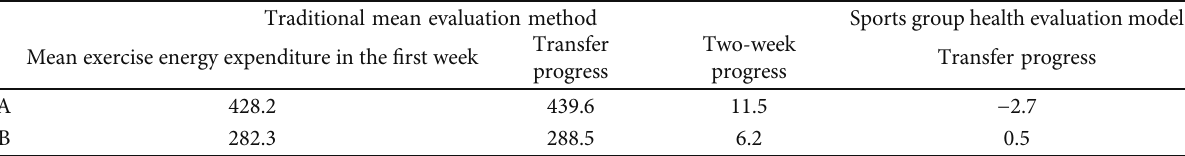
Table 8: Results of the traditional average of the two classes A and B and the group health evaluation